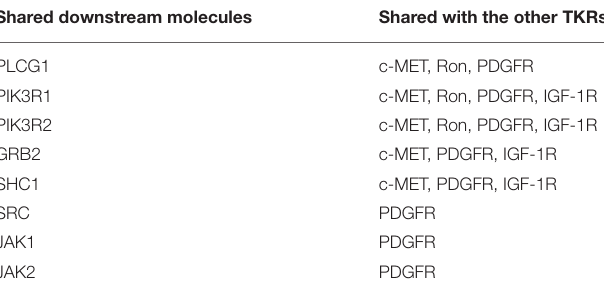
TABLE 1 | Direct downstream molecules of EGFR shared with the other TKRs.